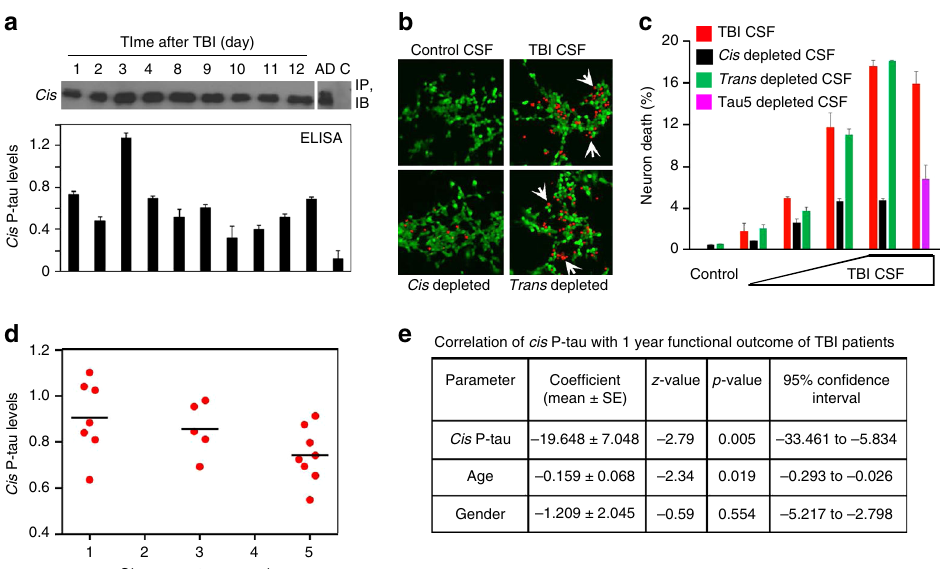
Fig. 2 Cis P-tau in the CSF of severe TBI patients is neurotoxic and correlates with clinical outcome at 1 year after injury. a Detection of cis P-tau in the CSF of a TBI patient was performed by subjecting control CSF or CSF specimens collected from EVD at different times after TBI due to jumping into an oncoming train to immunoprecipitation with cis mAb, followed by immunoblotting with rabbit anti-tau mAb (top panel) or to direct ELISA with cis mAb in OD at 450 nm (bottom panel). Post-mortem Alzheimer ’ s patient CSF (AD) and control CSF were used as positive and negative controls, respectively. b , c Addition of TBI CSF to neurons induces dose-dependent cell death in recipient cells, which are fully rescued by immunodepletion with cis , but not trans mAb. Human control and TBI CSF specimens were added to culture media of SY5Y neurons for 3 days, followed by the live (green)/dead (red, white arrows) cell assay. For immunodepletion, cis or trans mAb was incubated with TBI CSF to deplete cis or trans p-tau before adding to cells. n = 3. d , e Cis P- tau levels of CSFs taken day 4 to 6 days after injury of acute TBI patients were measured by direct ELISA and an ordered logistic regression was used to model 1 year GOS as the outcome and cis P-tau level in OD at 450 nm as the main predictor, controlling for age, gender and initial Glasgow Coma